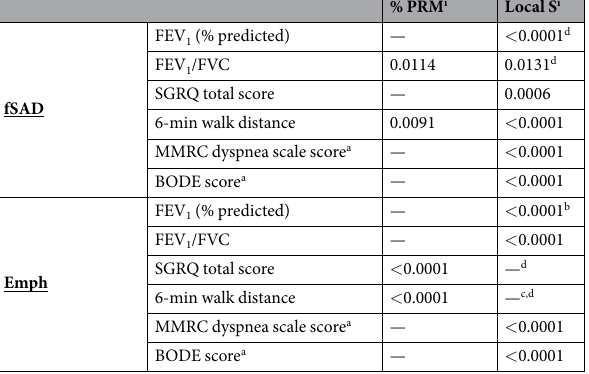
Table 1. Multivariate regression results. Note: Presented are the P values generated from stepwise regression models including the topological index S, respective PRM relative volume, age, gender, and body mass index (BMI). FEV 1 = forced expiratory volume in one second (% predicted); FVC = forced vital capacity; SGRQ =